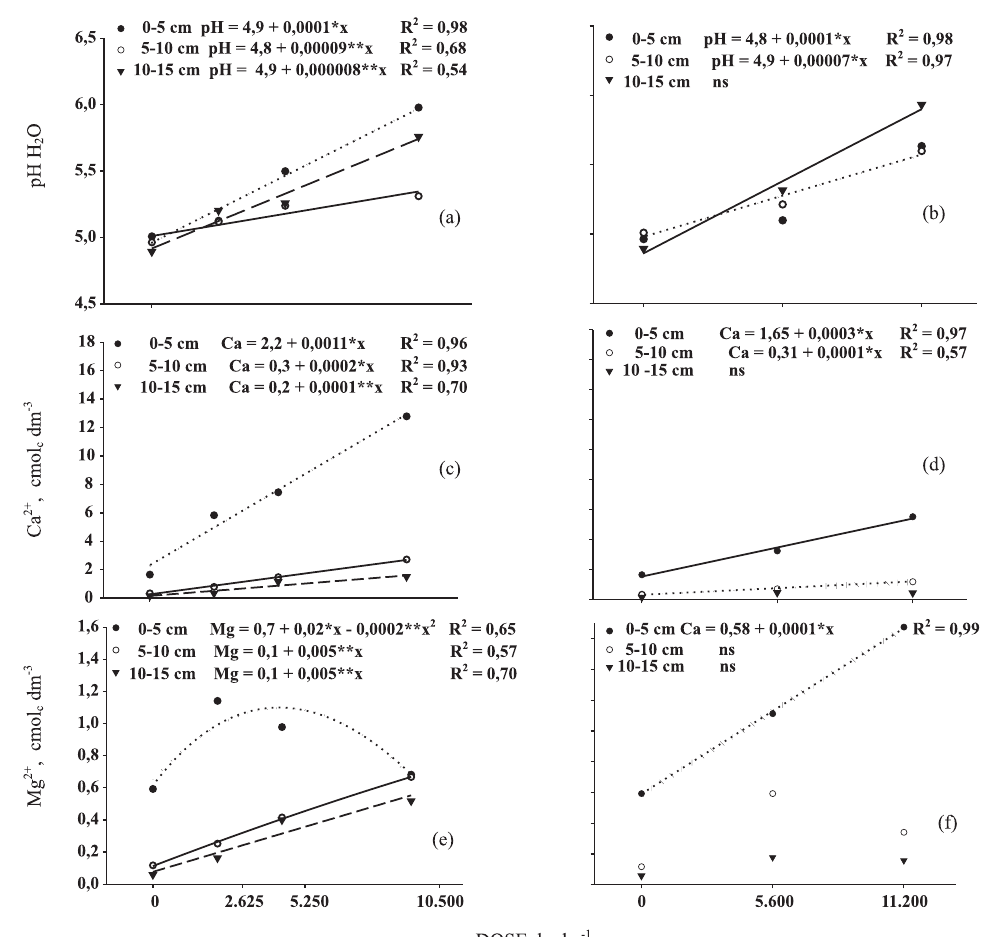
Figura 1. pH do solo (a) e (b), teores de cálcio (c) e (d); e de magnésio (e) e (f) de um Cambissolo Húmico alumínico corrigido com doses de resíduo alcalino (esquerda) e calcário (direita), aplicadas em superfície, calculadas com base no método SMP (*, ** e ns: significativo a 5 e 1 % e não